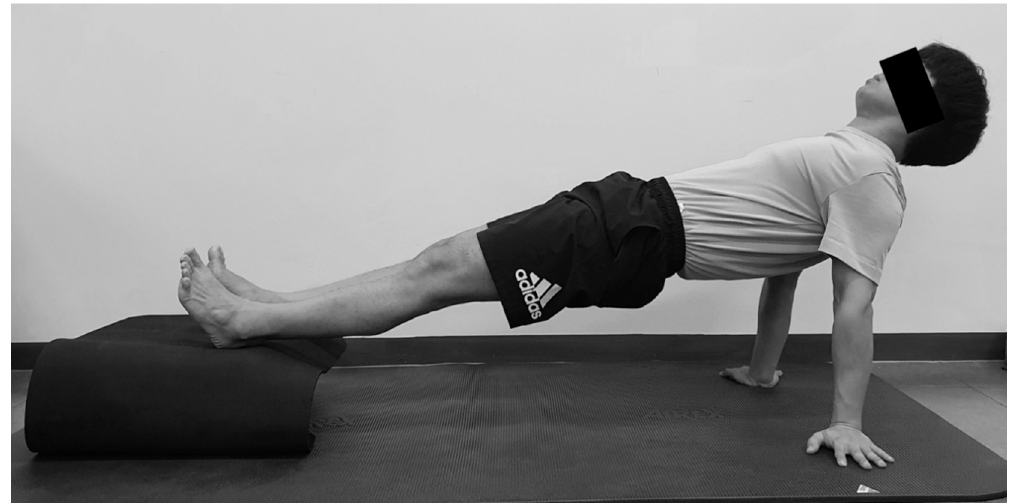
Figure 5. Hand-heel exercise.